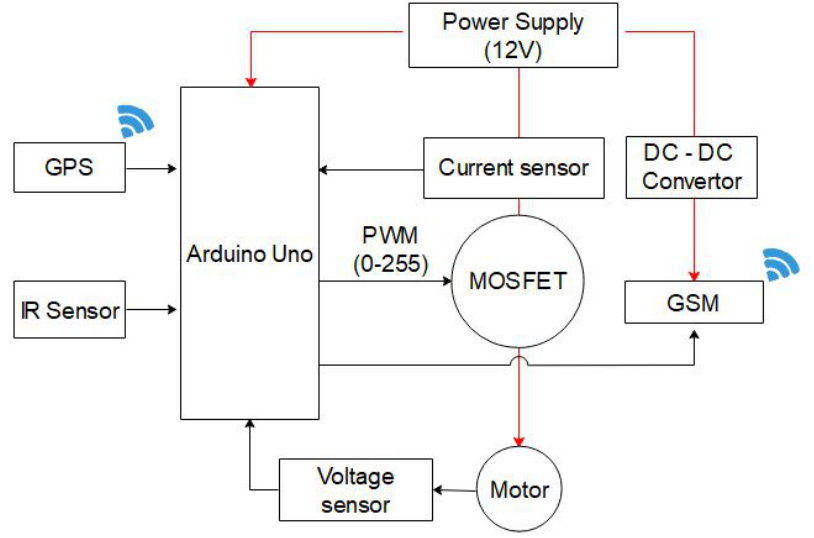
Figure 3. Architecture of the speed control system.